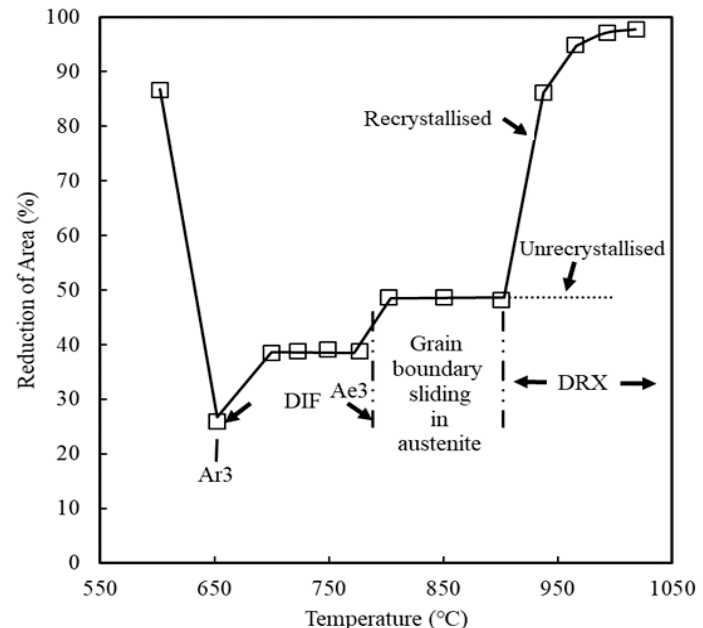
Figure 6. Hot ductility curve for a 0.4%C plain C-Mn steel tested at strain rate of 3 × 10 − 4 s − 1 having no micro-alloying precipitates present showing all the different regions that are possible in the trough on cooling down through the austenitic temperature range, region (i) deformation induced recrystallized austenite; (ii) un-recrystallized austenite undergoing grain boundary sliding; (iii) DIF (deformation induced ferrite) [3].